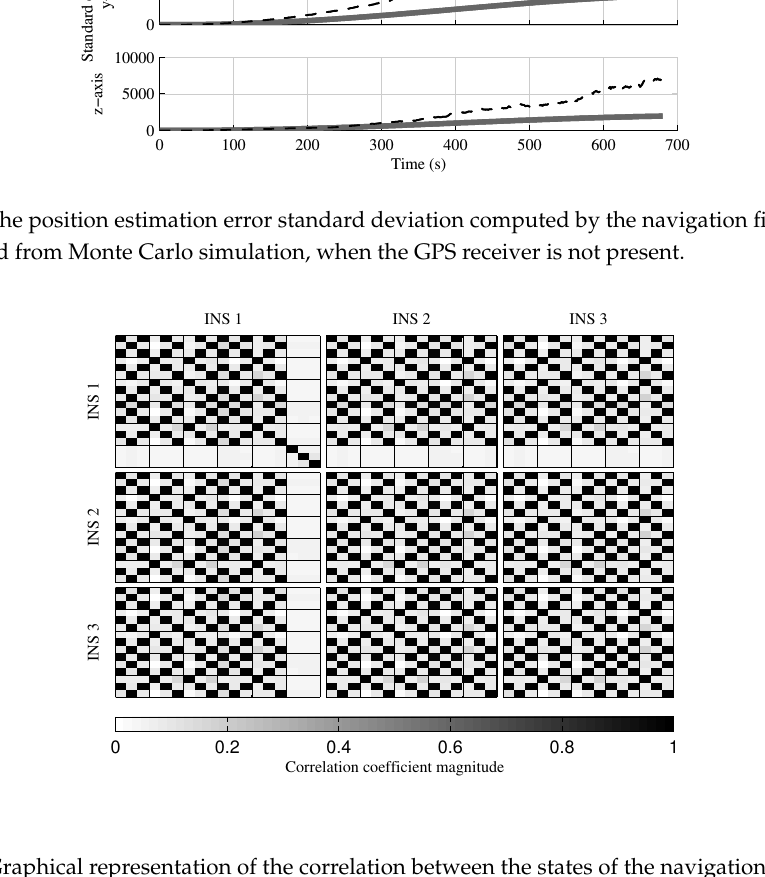
Figure 15. Graphical representation of the correlation between the states of the navigation filter at the 30th second of the simulation, when all geometrical constraints are